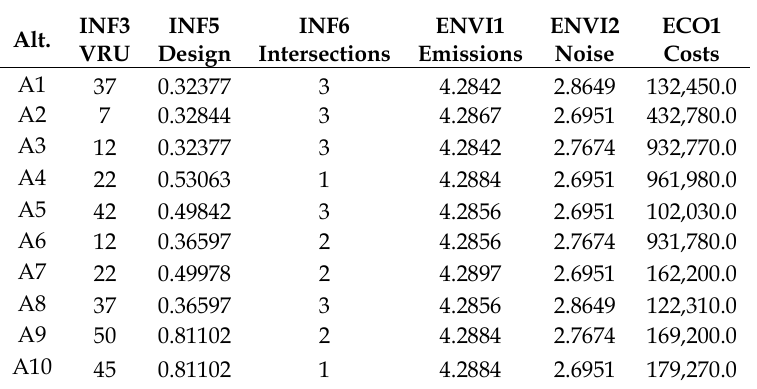
Table 6. Evaluation table of the multicriteria problem